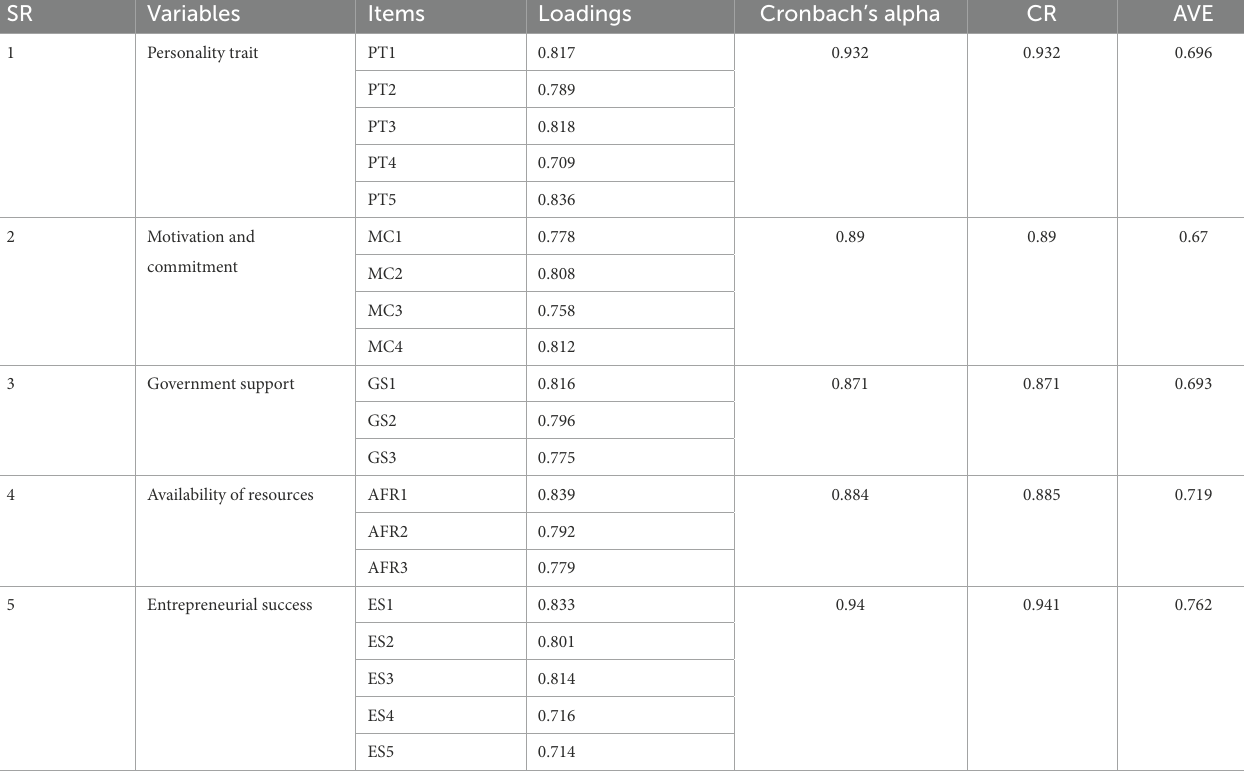
TABLE 3 Results of factor loadings, convergent validity, reliability, and descriptive statistics. SR